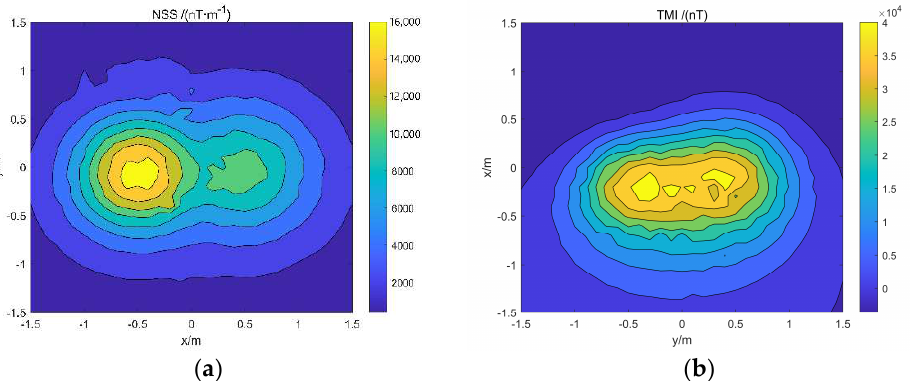
Figure 4. Model simulation data: ( a ) Simulation data for normalized magnetic source strength; ( b ) simulation data of the total magnetic field.